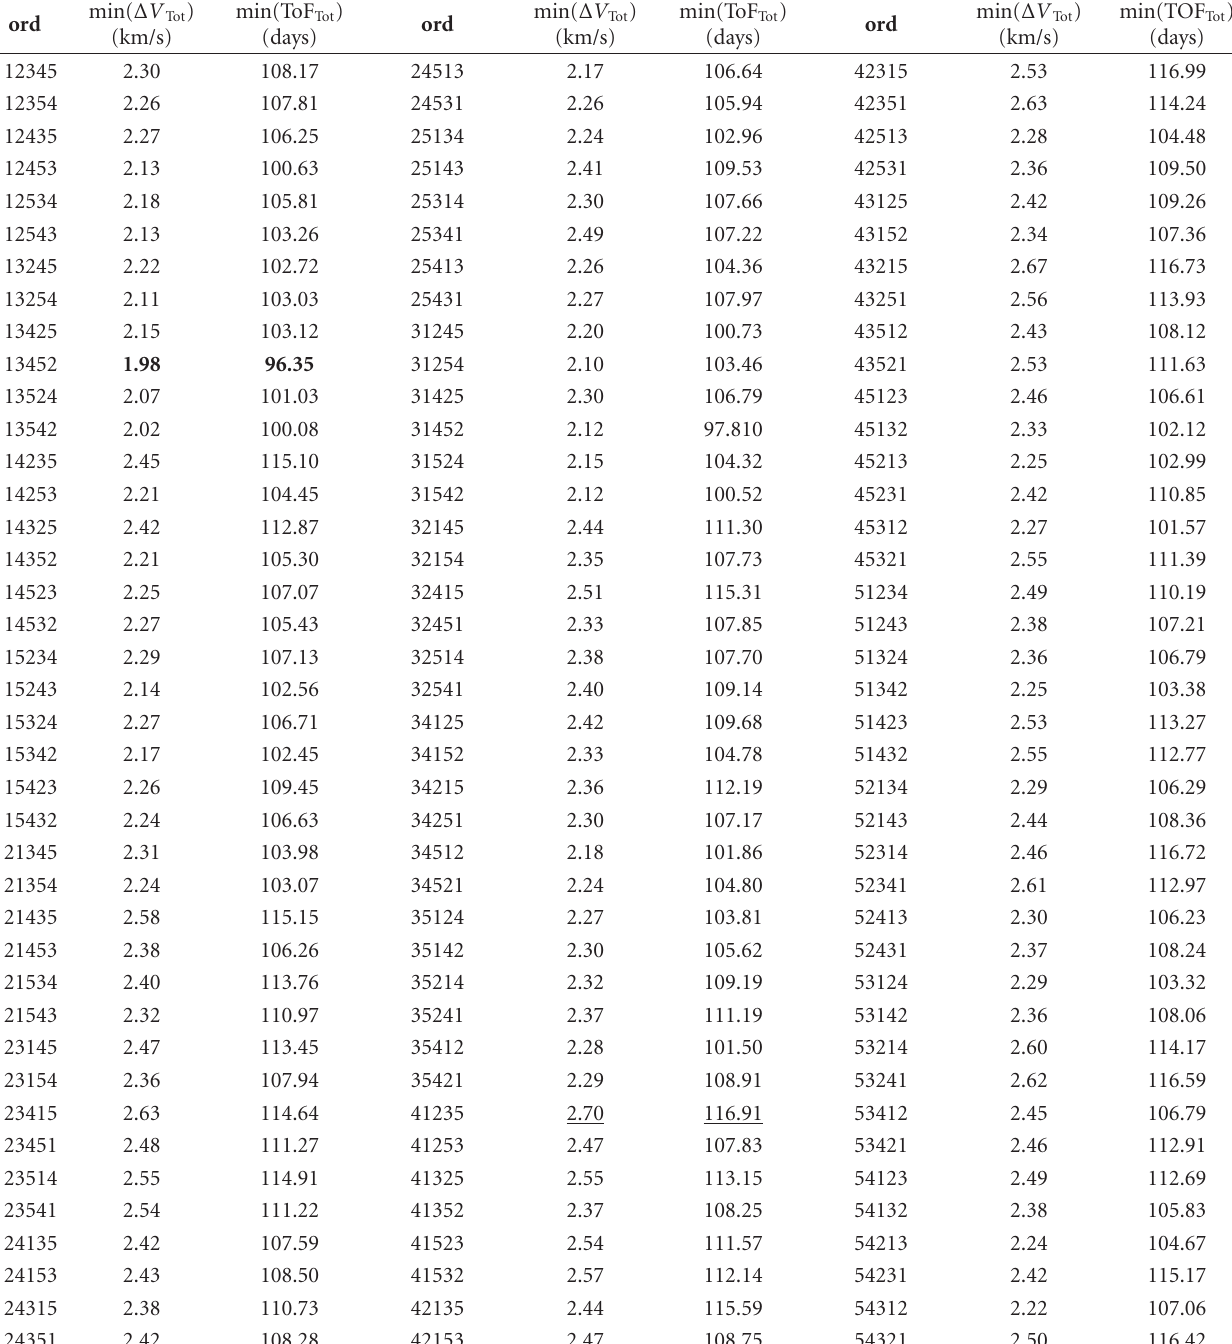
Table 7: Best Δ V Tot and ToF Tot for each sequence. Best values are in bold. Worst values are